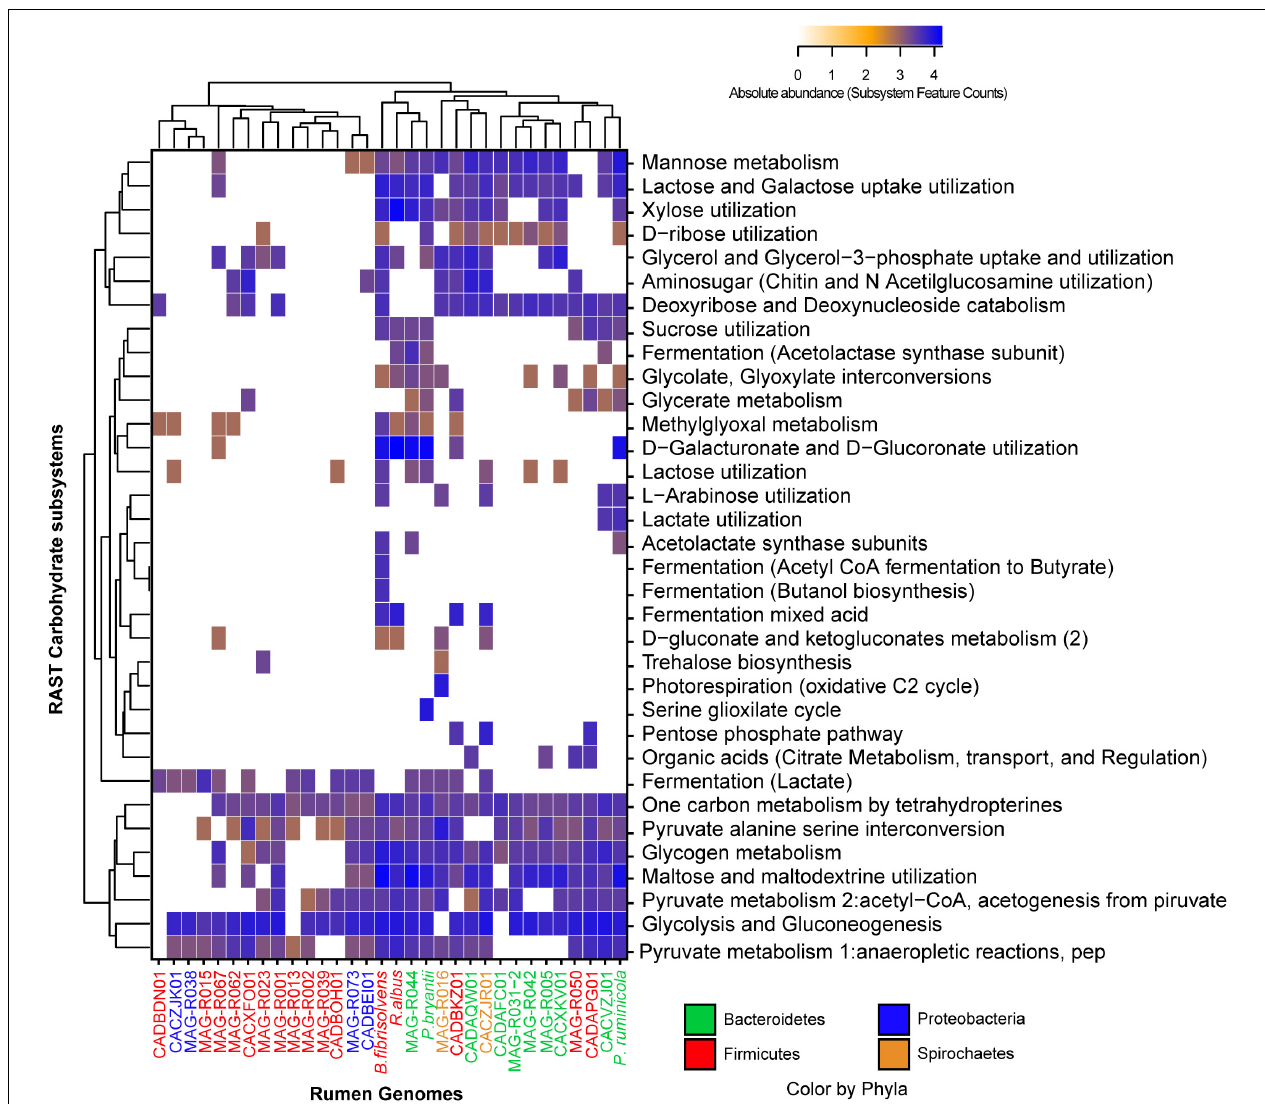
FIGURE 4 | Absolute abundance of the subsystem feature counts found in the carbohydrate category established by RAST (rapid annotation using subsystem technology) for each of the representative